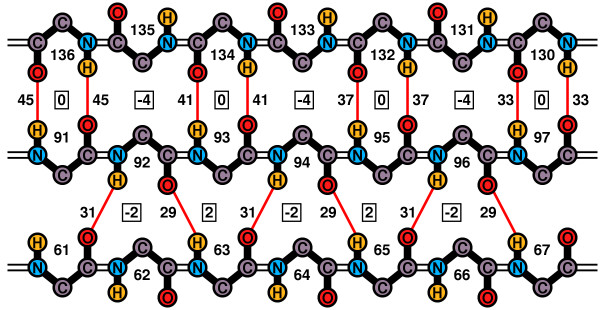
Ideal cases of a parallel and anti-parallel beta sheets. Residue numbers are surrounded by the backbone atoms of the respective residue, differences of hydrogen bonds are positioned next to the respective bonds and second differences are placed in boxes.